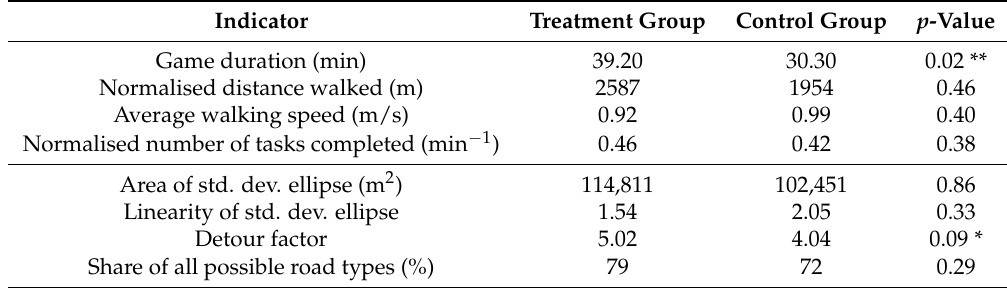
Table 1. Comparison of average values for the tested indicators. The first four measures listed are indicators of intrinsic and extrinsic properties of the game. The second half of the table gives indicators of the geographical exploration of the playing field. Note: * and ** indicate statistically significant mean differences at α = 0.1 and α = 0.05 respectively. We tested for differences in means using the non-parametric Mann–Whitney U test with the exception of the tasks completed. The latter variable was tested by means of a Student t test instead following a Shapiro–Wilk test for normality. Indicator Treatment Group Control Group p -Value Game duration (min) 39.20 30.30 0.02 ** Normalised distance walked (m) 2587 1954 0.46 Average walking speed (m/s) 0.92 0.99 0.40 Normalised number of tasks completed (min − 1 ) 0.46 0.42 0.38 Area of std. dev. ellipse (m 2 ) 114,811 102,451 0.86 Linearity of std. dev. ellipse Detour